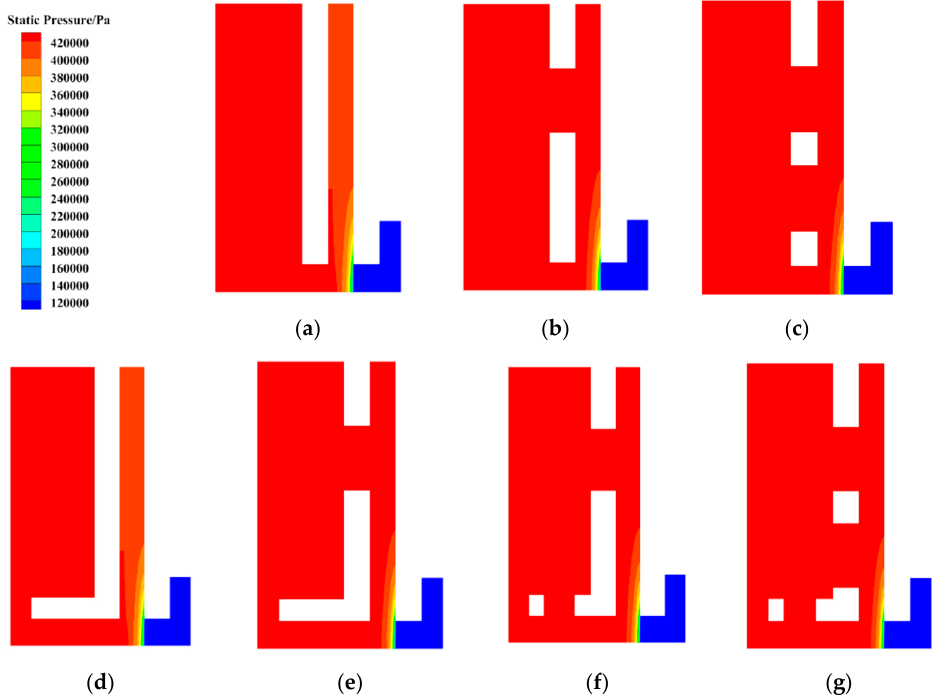
Figure 8. Static pressure contours: ( a ) Case-1; ( b ) Case-2; ( c ) Case-3; ( d ) Case-4; ( e ) Case-5; ( f ) Case-6; ( g ) Case-7.